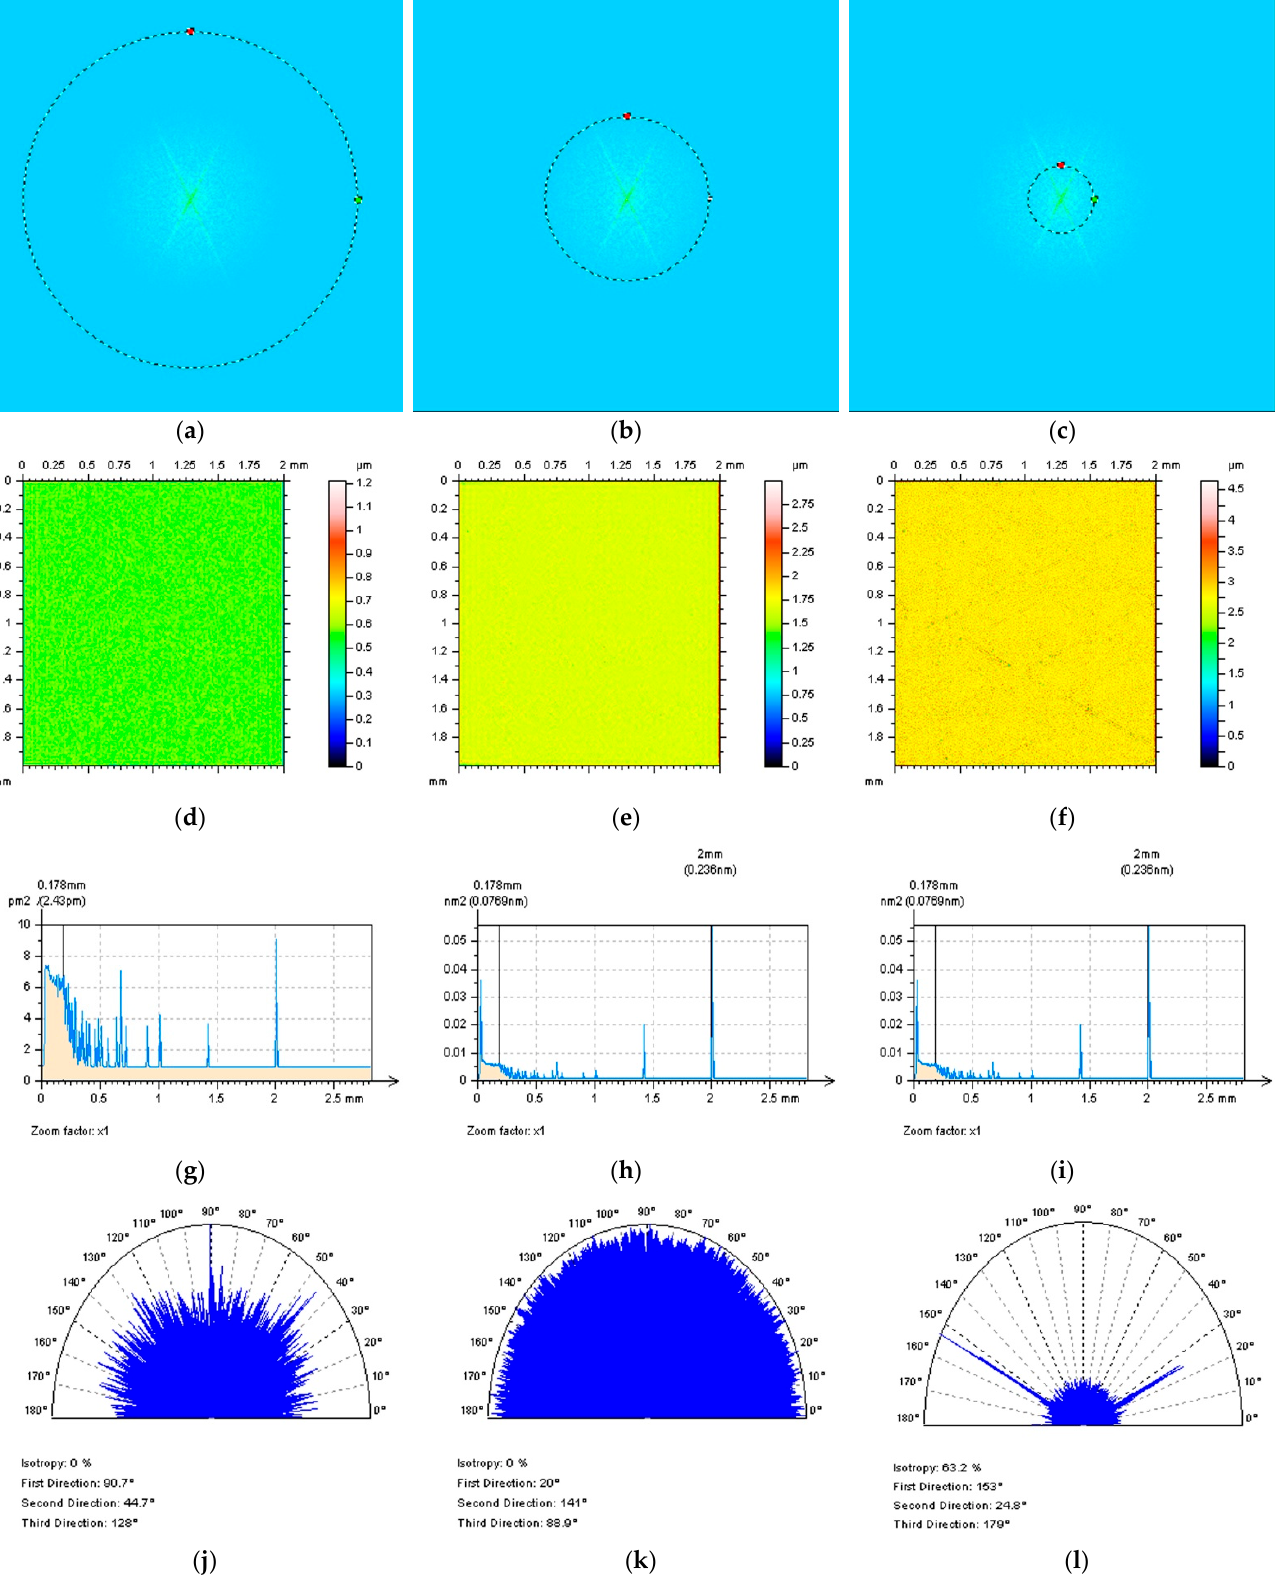
Figure 5. Spectrum edition ( a – c ), HFNS ( d – f ), their PSDs ( g – i ) and TDs ( j – l ) from a plateau ‐ honed cylinder liner surface texture received after application of FFTF method. cylinder liner surface texture received after application of FFTF